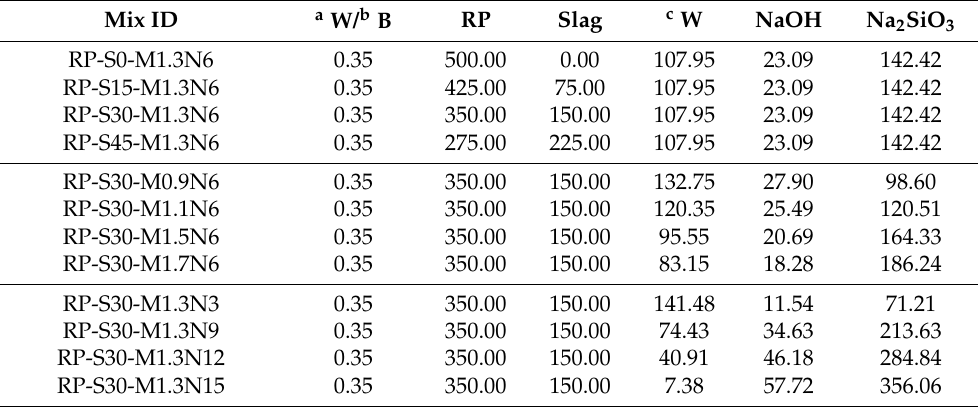
Table 2. The mixture proportions of